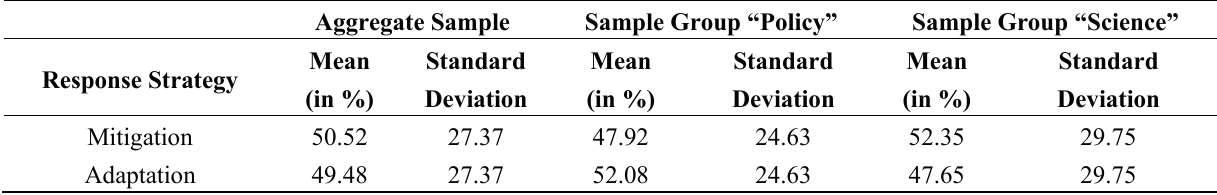
Table 3. Assessment of the percentage committed to mitigation and adaptation response strategies under budgetary constraints, by the aggregate sample and the two sample groups “Policy” and